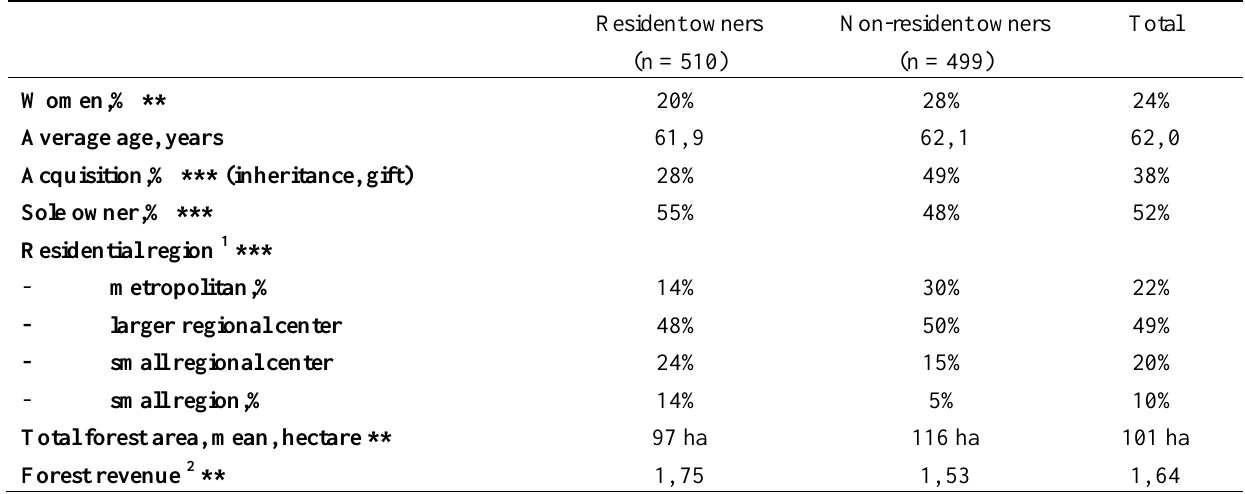
Table 2. Socio-demographic and value characteristics of resident and non-resident forest